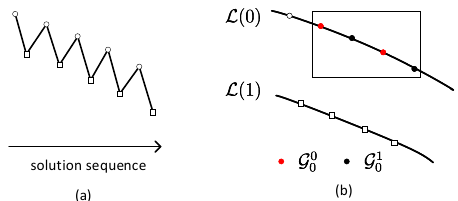
Figure 4. An example of illustration of the lanes, windows, and groups in the method ( N = 2, W = 4, G = 2). ( a ) The solution sequence as the time step advances; the points with different shapes represent solutions from different correctors. ( b ) The partition of the linear systems, and each line represents a lane; the rectangle represents the window; the points with different colors belong to different